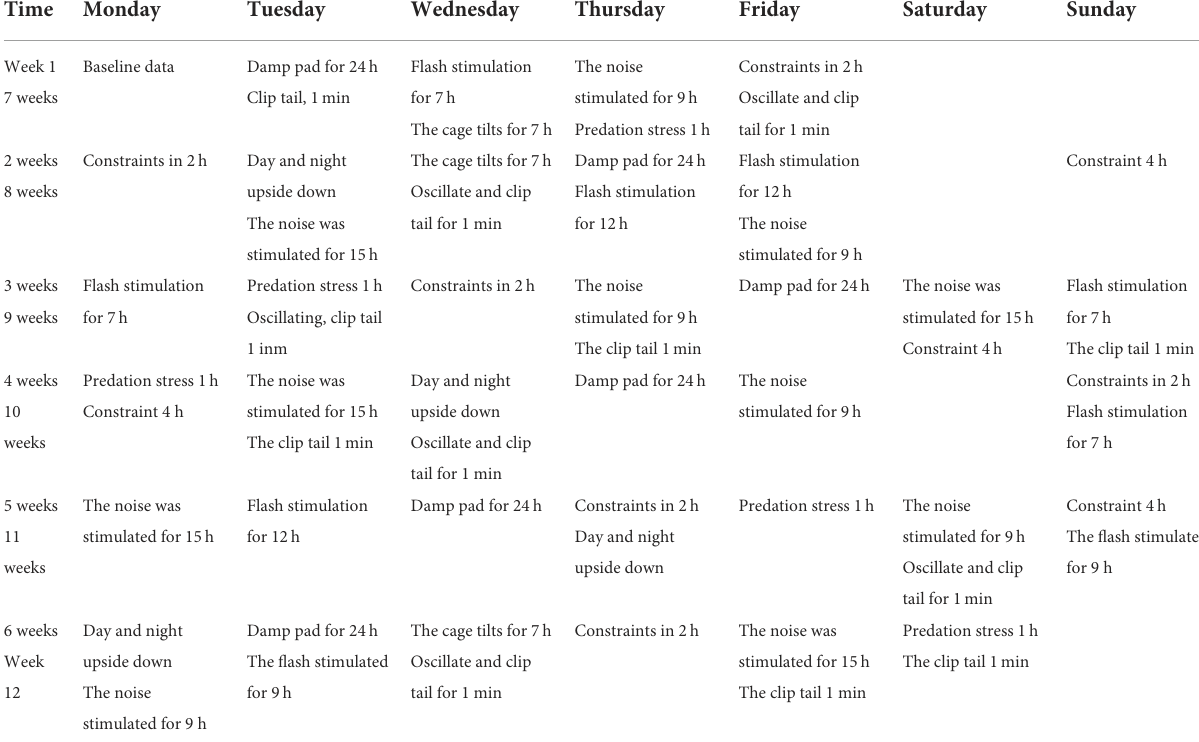
TABLE 1 Procedure of chronic stress for 12